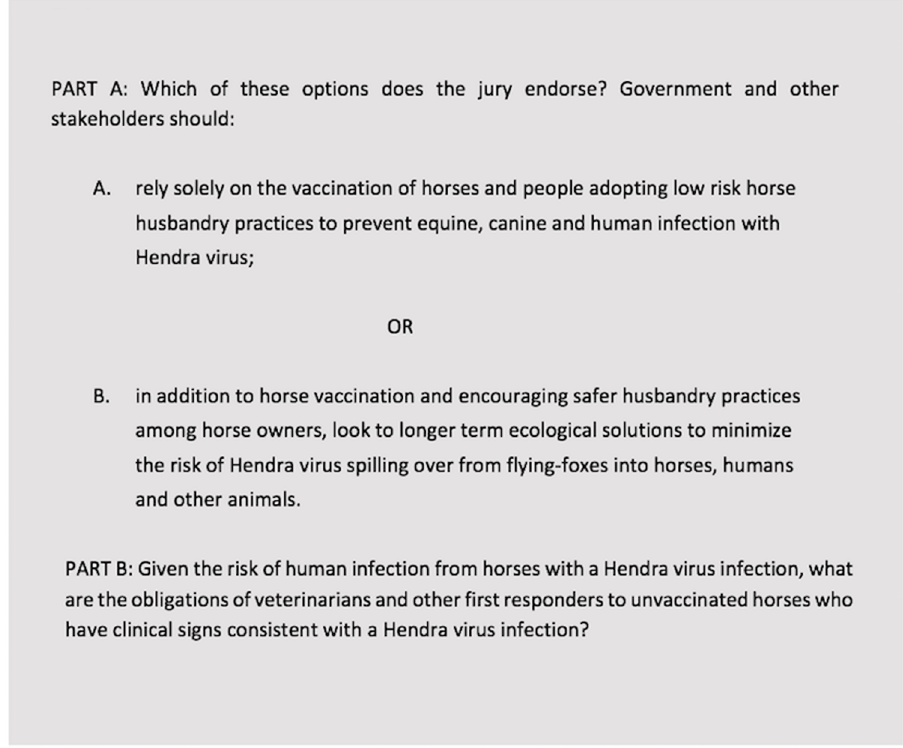
Fig 1. Questions for the community juries.